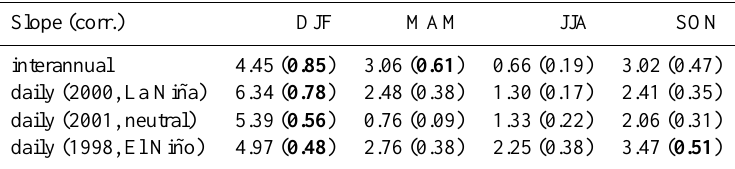
Table 1. Slopes (Unit: % per K) of linear regression and correlation coefficients between area-averaged (70 ◦ –110 ◦ W, 10 ◦ –30 ◦ S) adjusted low cloud amount and LTS on interannual and daily timescales grouped by different seasons. Correlation coefficients with significance at the 95% level using the Student-t test are bolded.